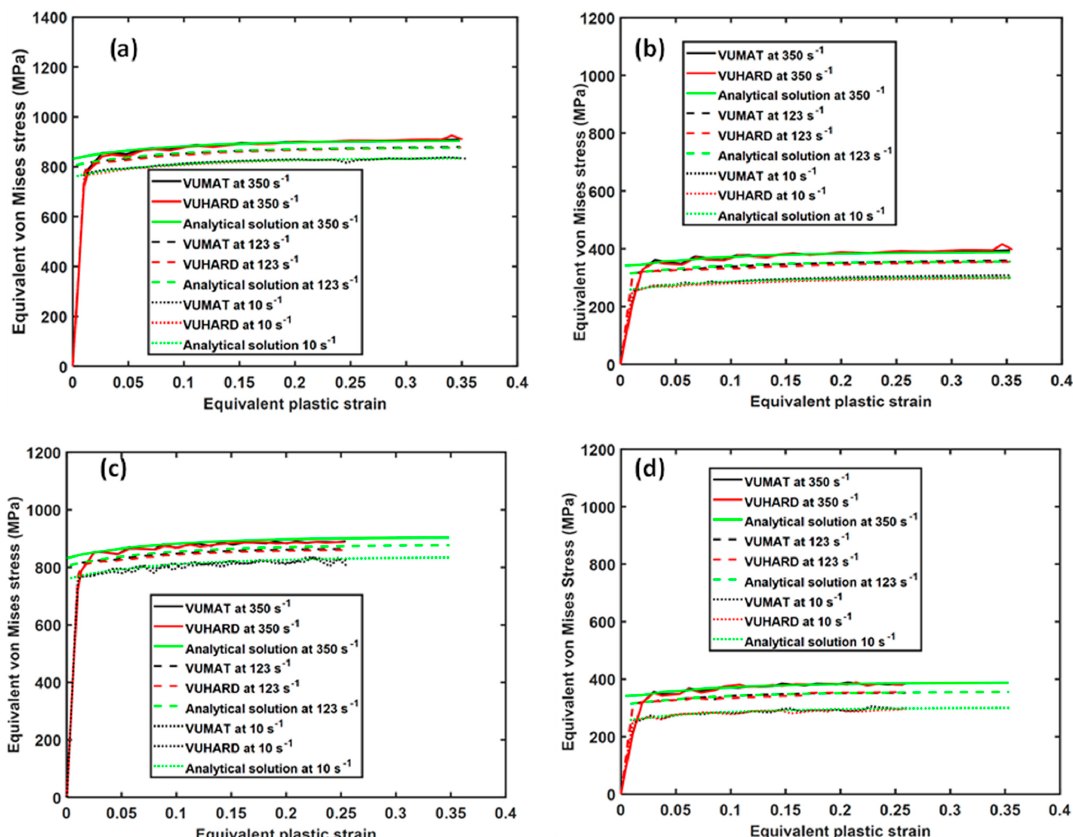
Figure 11. Comparison between the analytical and numerical solutions in VUMAT and VUHARD at three different test velocities and temperatures of ( a , c ) 298 K and ( b , d ) 773 K for an 8-node linear brick element in ( a , b ) compression and ( c , d ) tension for samples E.